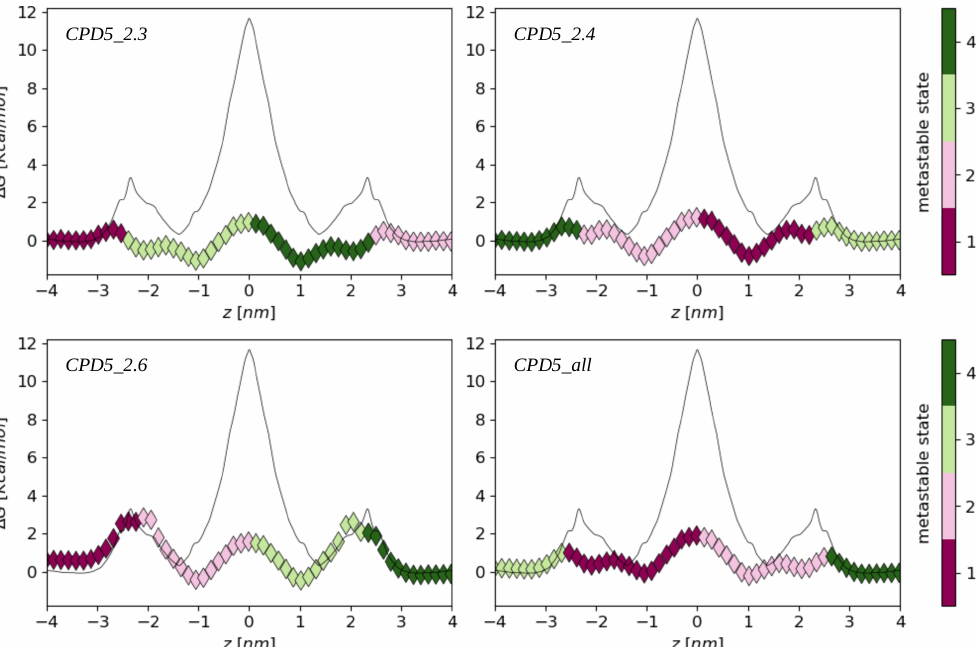
Figure 2. CDP5 free energy profiles computed from four different sets of unconstrained trajectories (Section 3.3). Diamonds indicating the discrete states are colored according to the metastable state to which they belong. FEPs were set to zero in the water phase, including the FEP computed from US trajectories (black